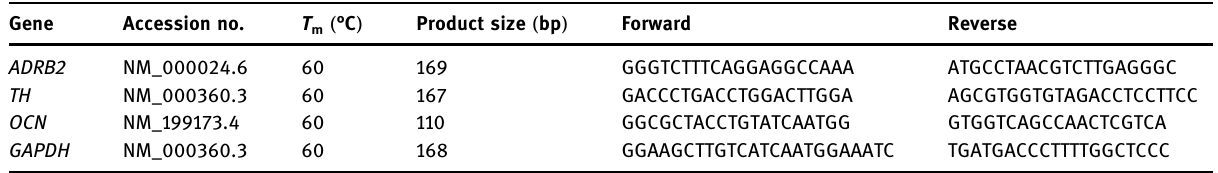
Table 1: Primer sequences used in RT - qPCR